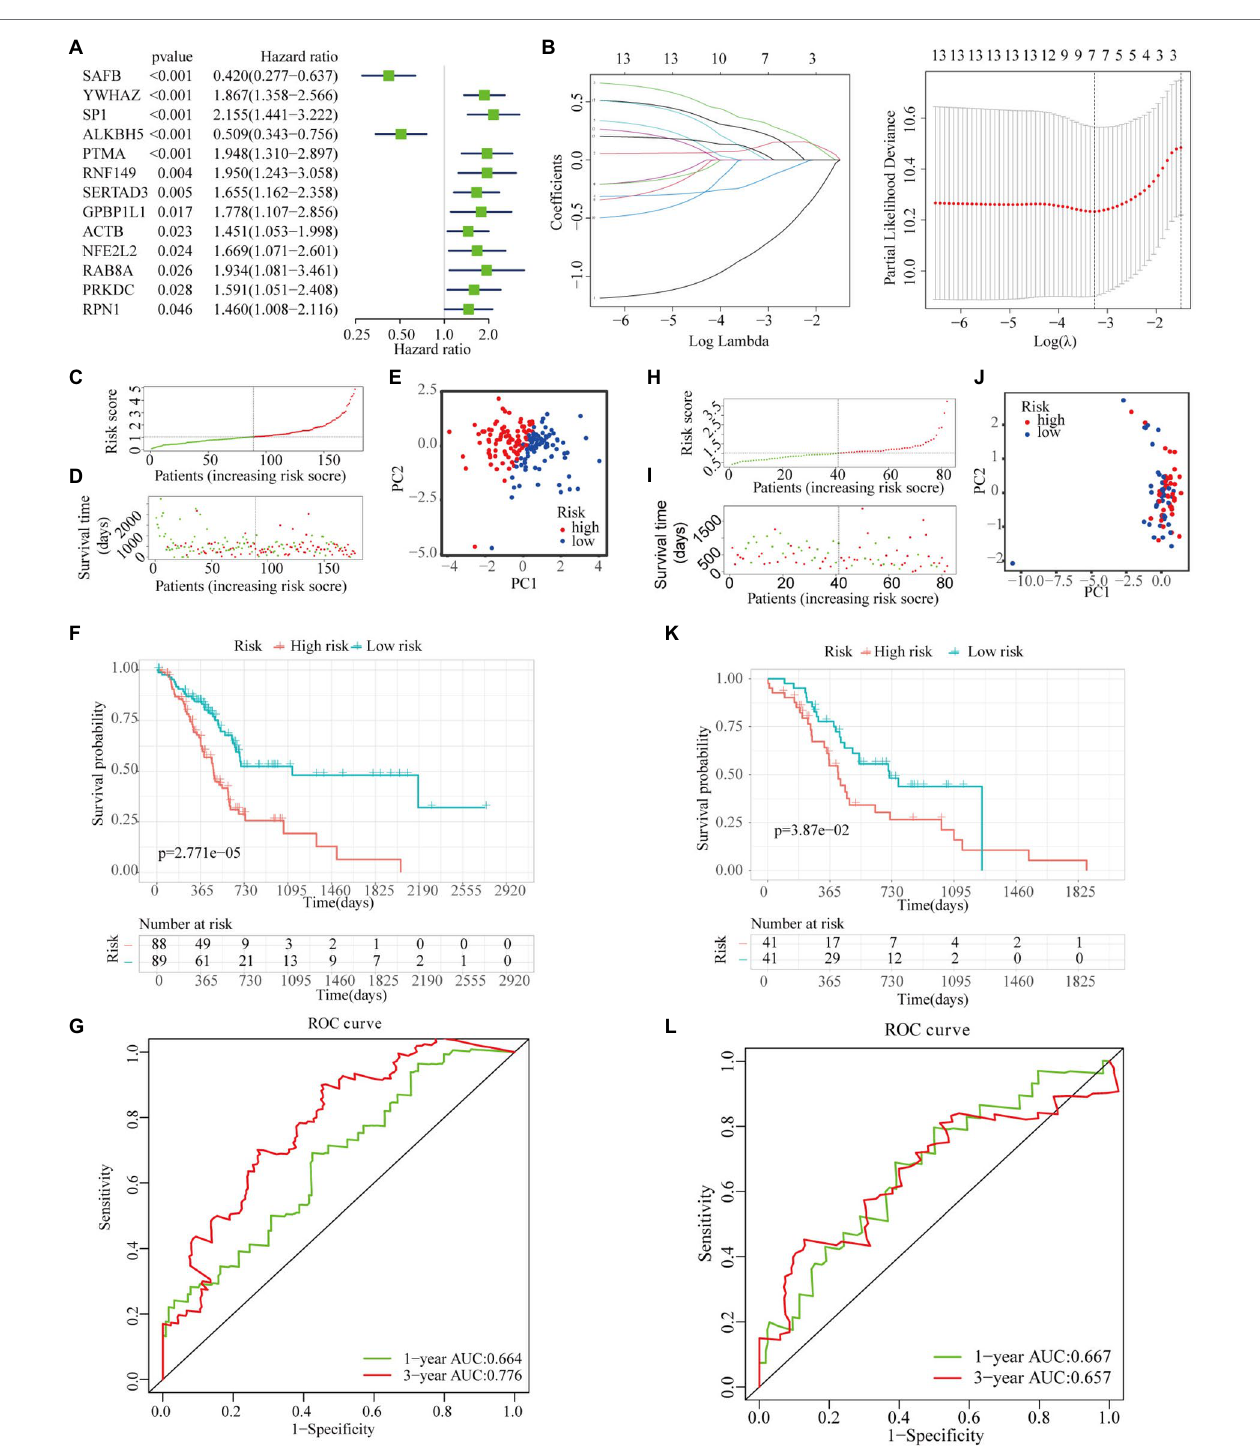
FIGURE 6 | Construction and validation of a novel multigene prognostic signature. (A) Univariate Cox regression analysis of all the genes in the brown module. (B) The coefficients calculated by the LASSO regression analysis are shown in the TCGA cohort. (C) The distribution and median value of the risk scores in the TCGA cohort. (D) The distributions of OS status, OS, and risk score in the TCGA cohort. (E) The principal component analysis (PCA) plot of TCGA cohort. (F) The Kaplan–Meier curves for the OS of patients in the high- and low-risk subgroups in the TCGA cohort. (G) The AUC of time-dependent receiver operating characteristic (ROC) curves in the TCGA cohort. (H) The distribution and median value of the risk scores in the International Cancer Genome Consortium (ICGC) cohort. (I) The distribution of OS status, OS, and risk score in the ICGC cohort. (J) The PCA plot of the TCGA cohort. (K) The Kaplan–Meier curves for the OS of patients in the high- and low-risk groups in the ICGC cohort. (L) The AUC of the time-dependent ROC curves in the ICGC